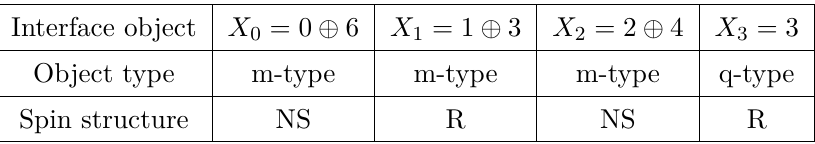
Table 2 . Interface objects after condensing 6 in su (2) 6